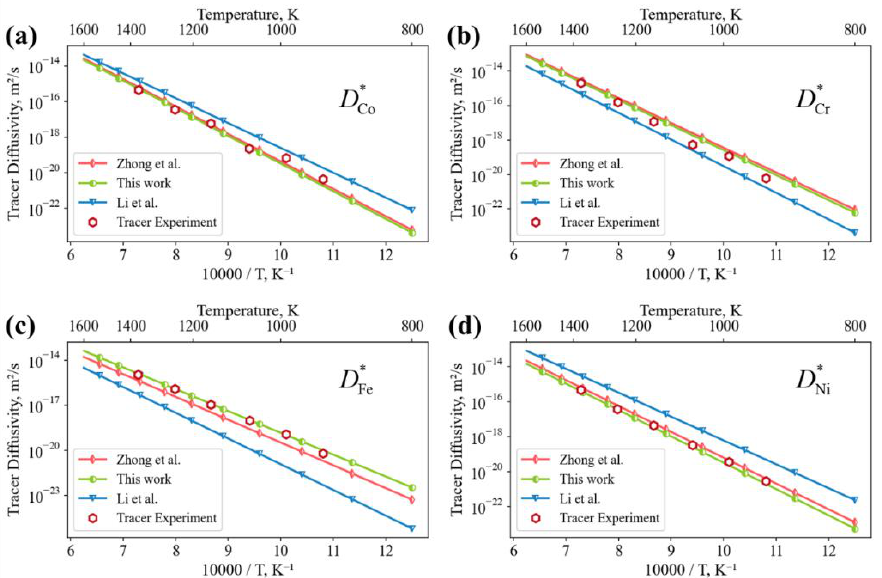
Figure 4. Comparison between the tracer diffusion coefficients evaluated by different researchers [20,24,35] and optimization results in the present work: ( a ) D ∗